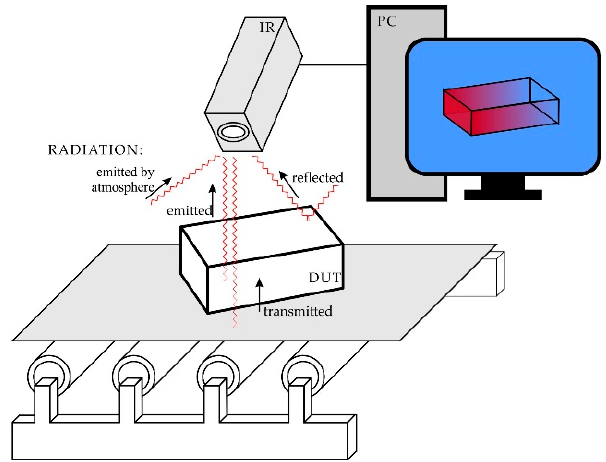
Figure 2. Exemplary production line quality control system with a device under test (DUT) inspected with the help of an infrared camera (IR)—sources of radiation received by the camera have been presented.